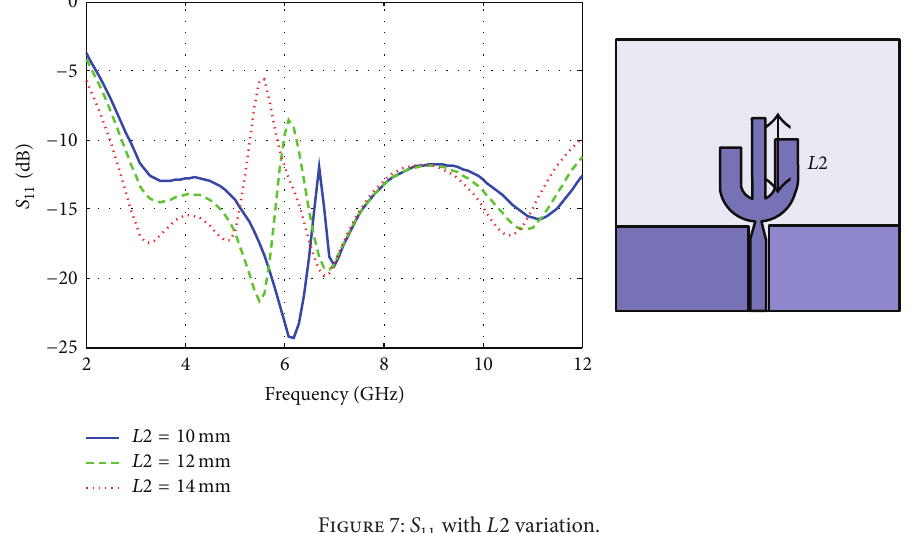
Figure 7: 𝑆 11 with 𝐿 2 variation.